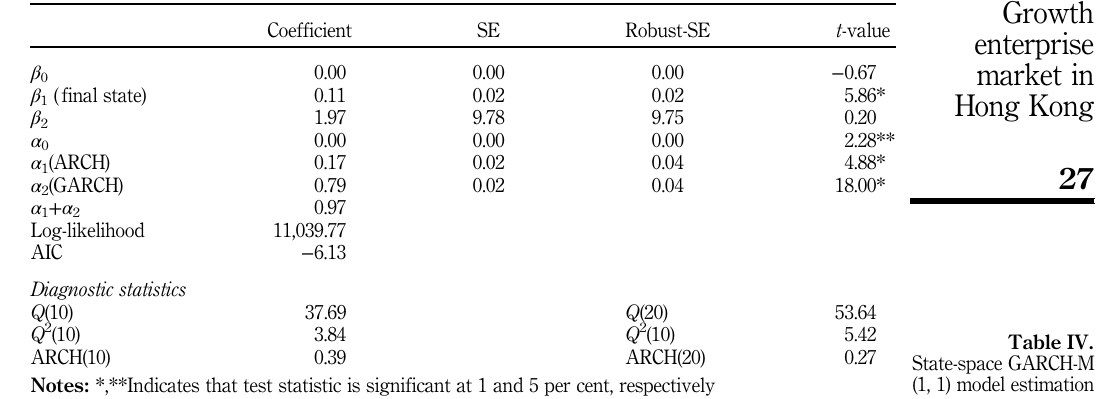
Table IV. State-space GARCH-M (1, 1) model estimation